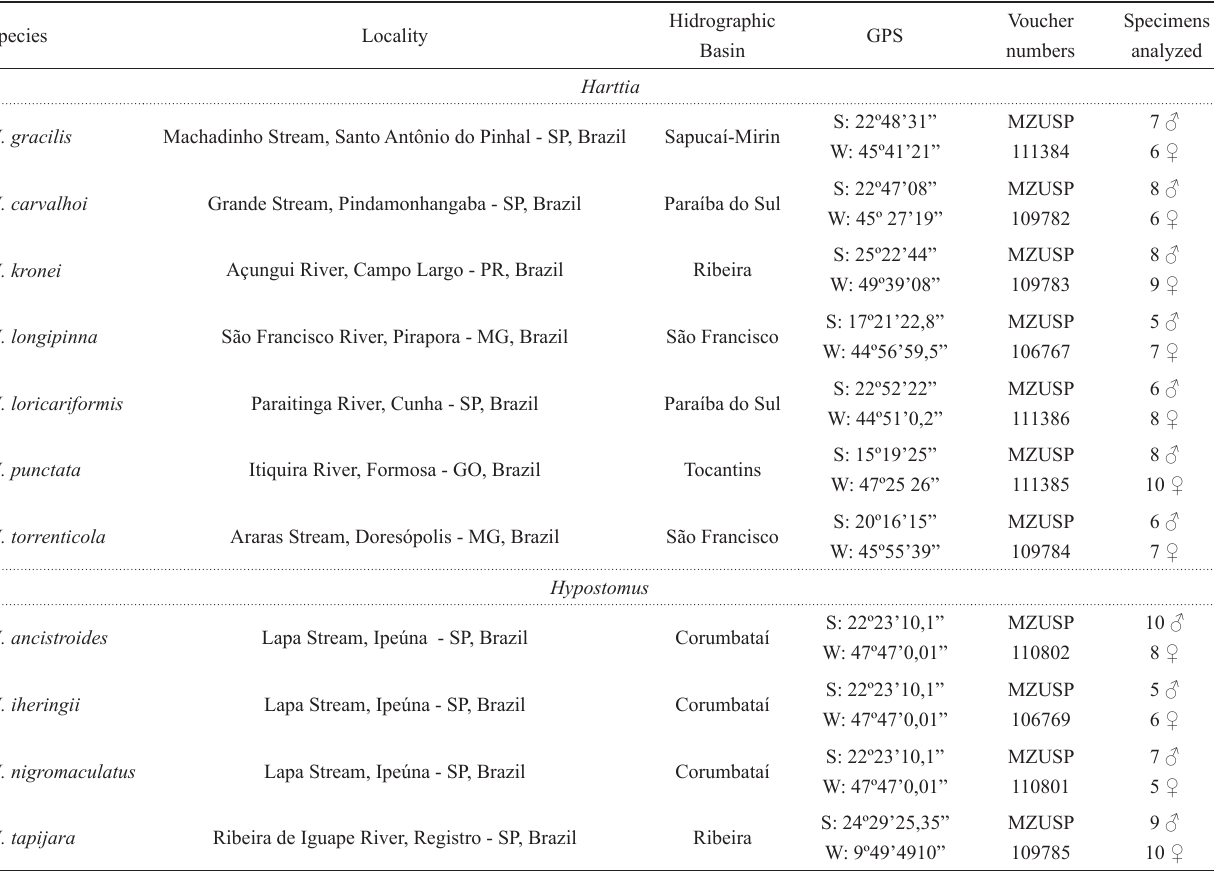
Tab. 1. Information of the species collected.